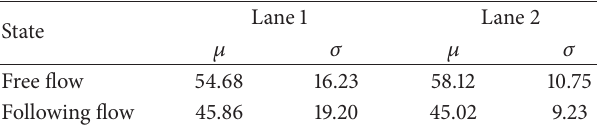
Table 6: Parameters of the Gaussian distribution for speed with different flow states.